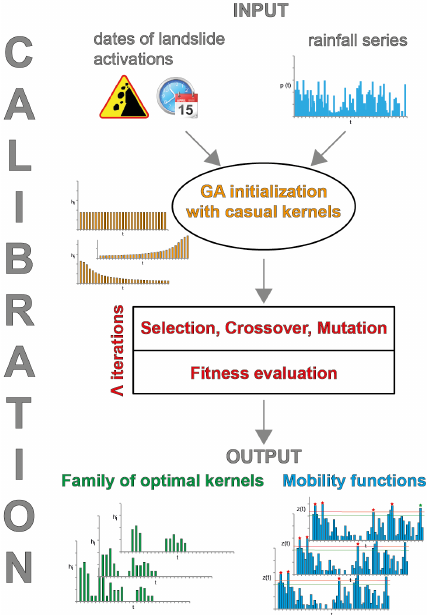
Figure 1. Scheme of the calibration procedure of the GA SAKe